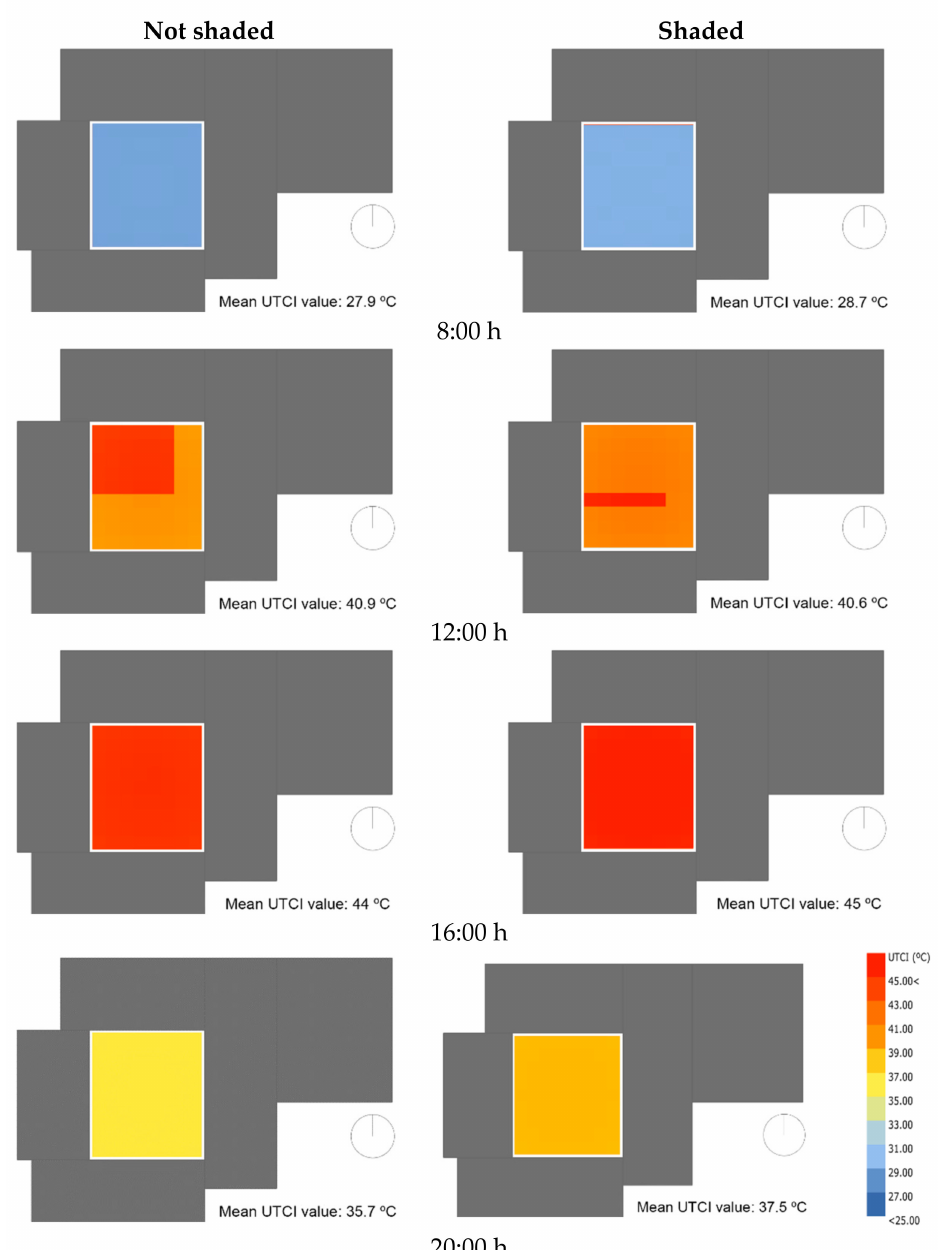
Figure 8. UTCI values at a 1.5 m height in the courtyard at different hours based on the ENVI-met simulation workflow. Left : without shading. Right : shaded. Table 4. Simulated mean UTCI values at 1.5 m in the courtyard at different hours of the day.